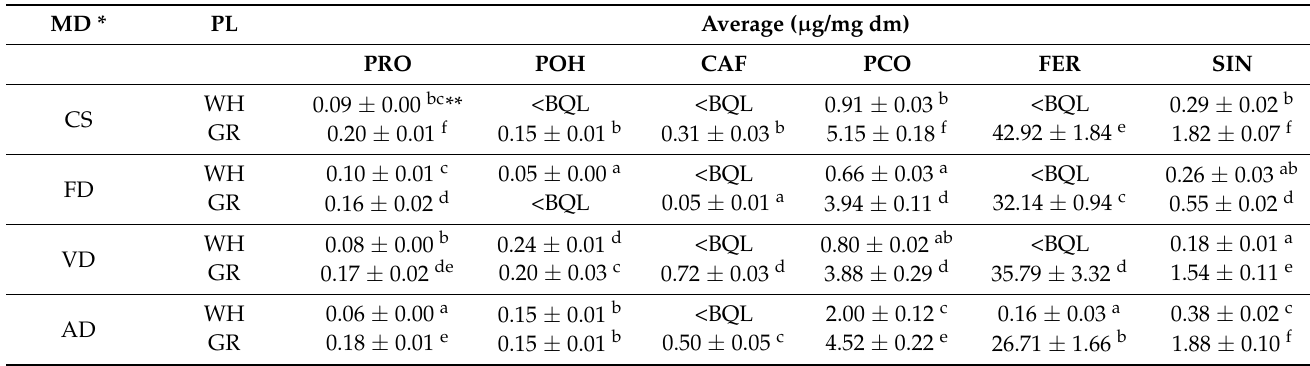
Table 6. Identified and marked phenolic acids in a white and green shaft of the leek.